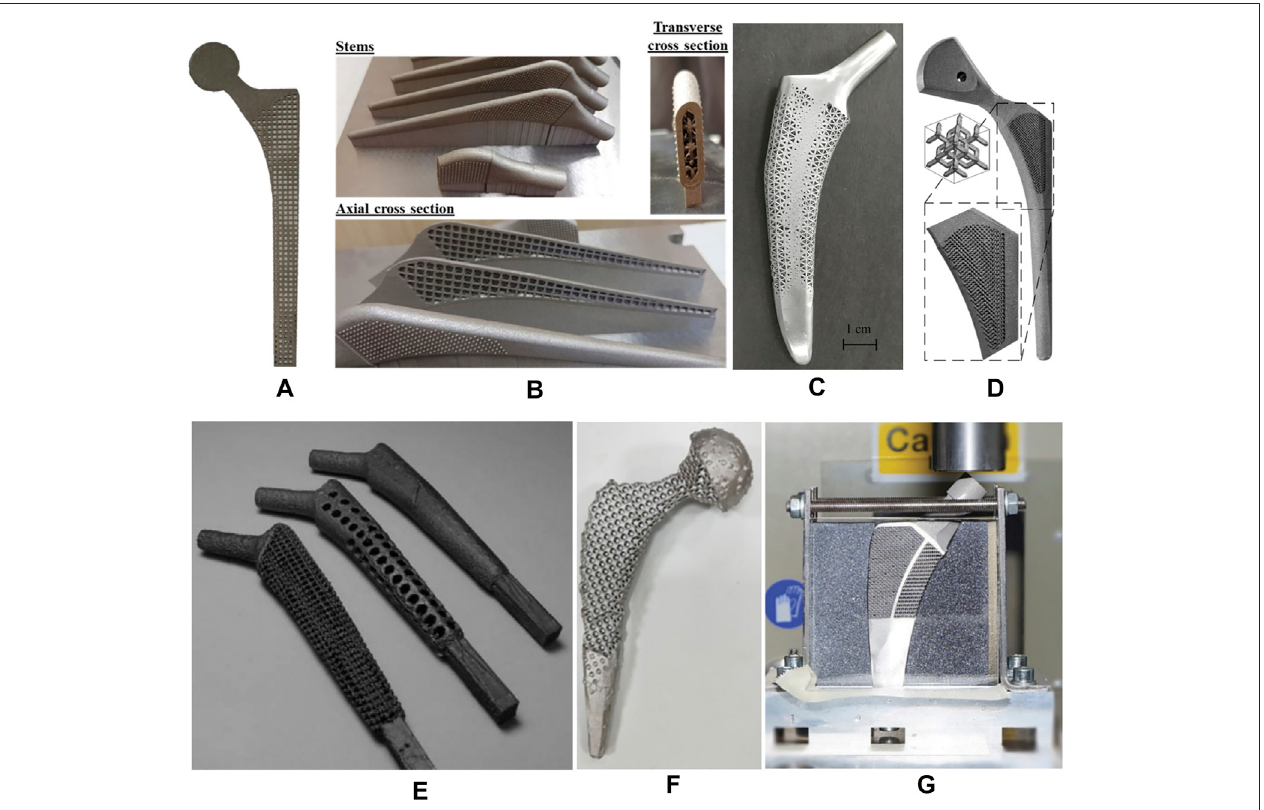
FIGURE3| Femoralstemwithregularporousstructure. (A) 2Dfemoralstemusingsquareunit cellsdesignedbyArabnejad Khanokiand Pasini(2013); (B) femoral stemusingBCCunitcellsdesignedbyMehboobetal.(2018) (C) femoralstemusingtetrahedraltopologydesignedbyWangetal.(2018); (D) Stemusingdiamondlattice unit cells designed by Jette et al. (2018); (E) Stem using Rhombic dodecahedron unit cells designed by Harrysson et al. (2008) (F) Stem using vintile lattice unit cells by Abate et al.; (Abate et al., 2019; Abate et al., 2021); (G) Meta stem designed by Kolken et al. (2018), with the lateral part of the femoral stem having a re-entrant honeycomb structure and the medial part having a honeycomb